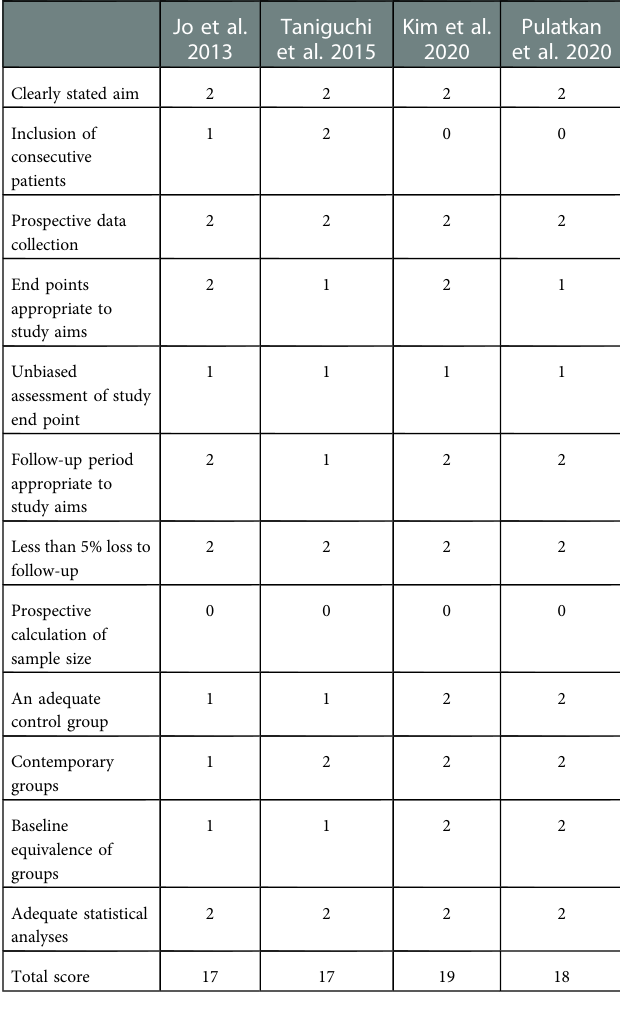
suggested that there were no signi fi cant differences between microfracture, ACI, and OAT in improving function and pain at intermediate-term follow-up.